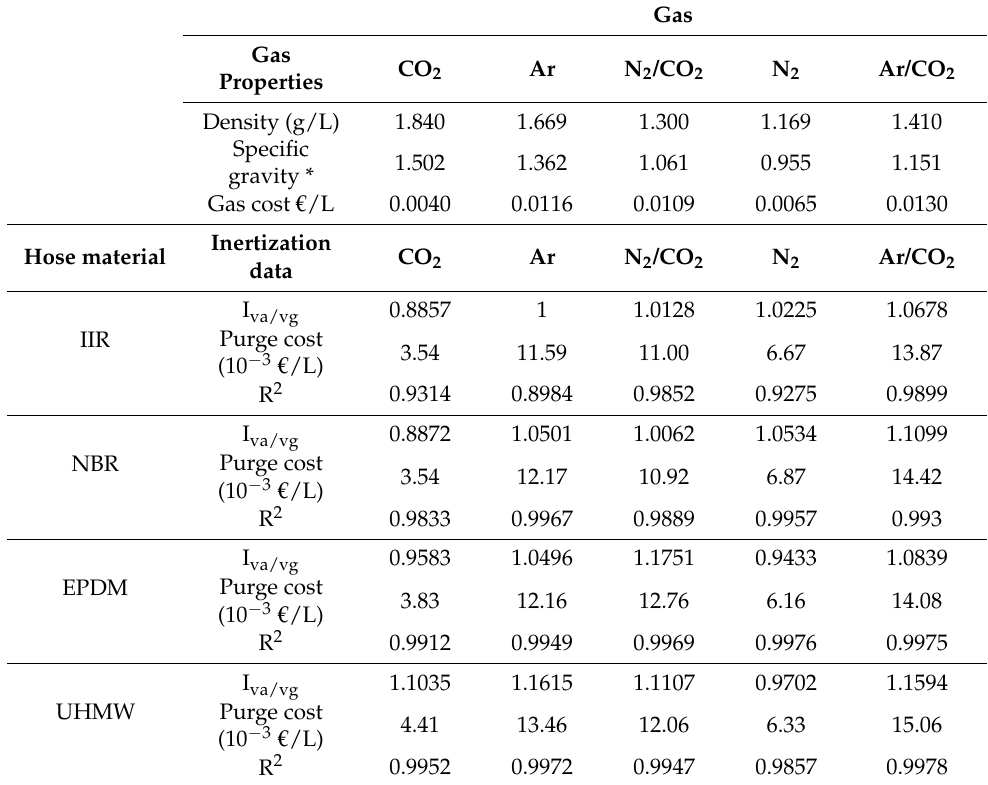
Table 10. Comparison of the inert gas volume for a complete purge index as well as the cost for the inert gases tested in the different hoses